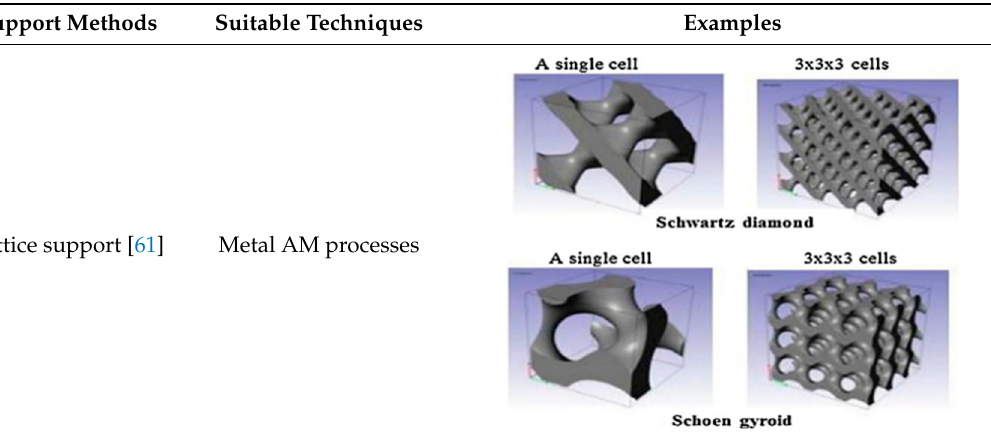
Table 2. Demonstration of main support methods.